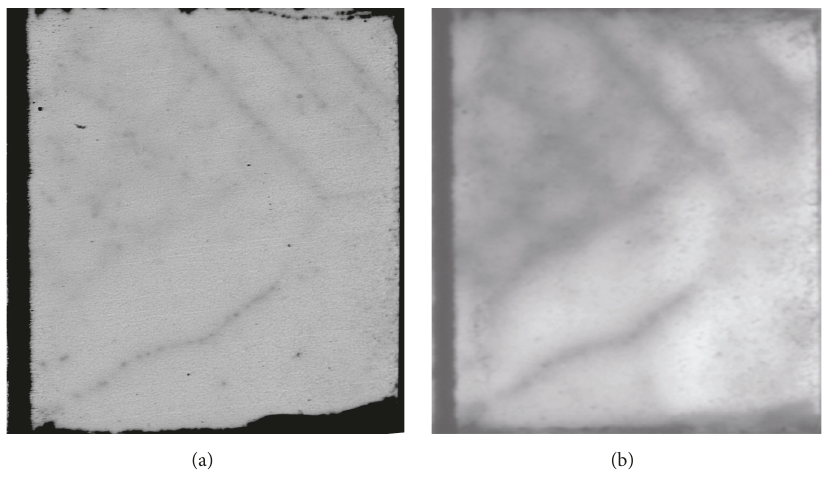
Figure 3: EBIC (a) and LBIC (b) images of the same region as in Figure 2.